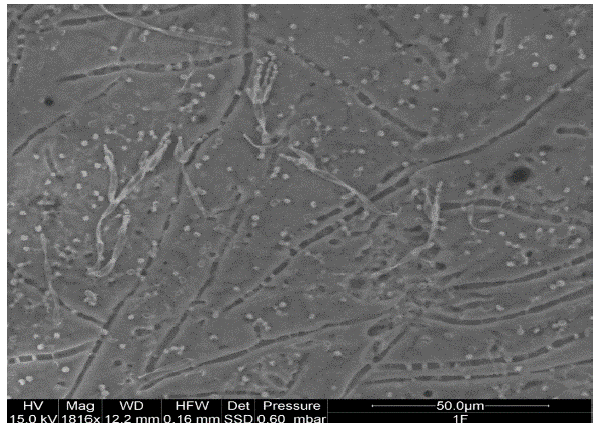
Figure 2. Representative visual observations of the positive cultures in cetrimide agar of P. aeruginosa ATCC 9027 from each inoculated resin.